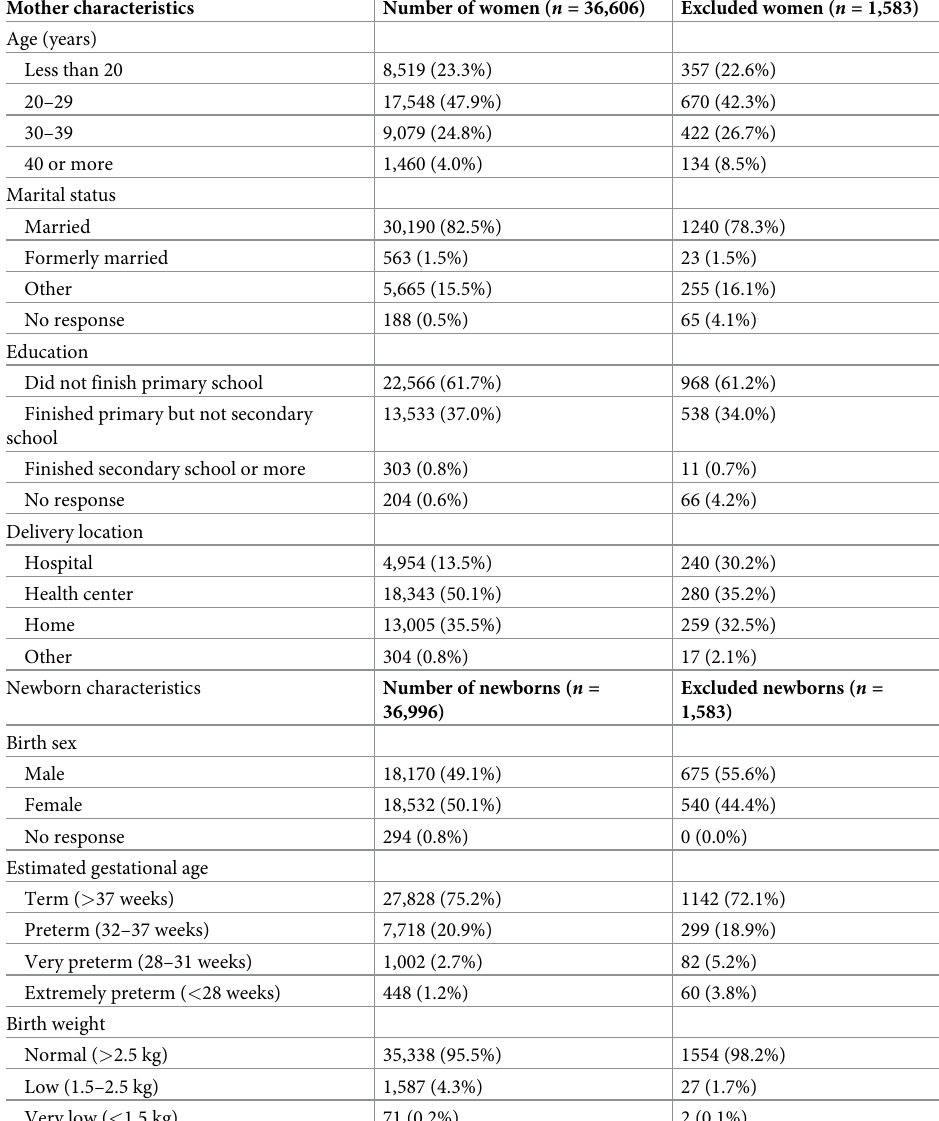
Table 1. Participant